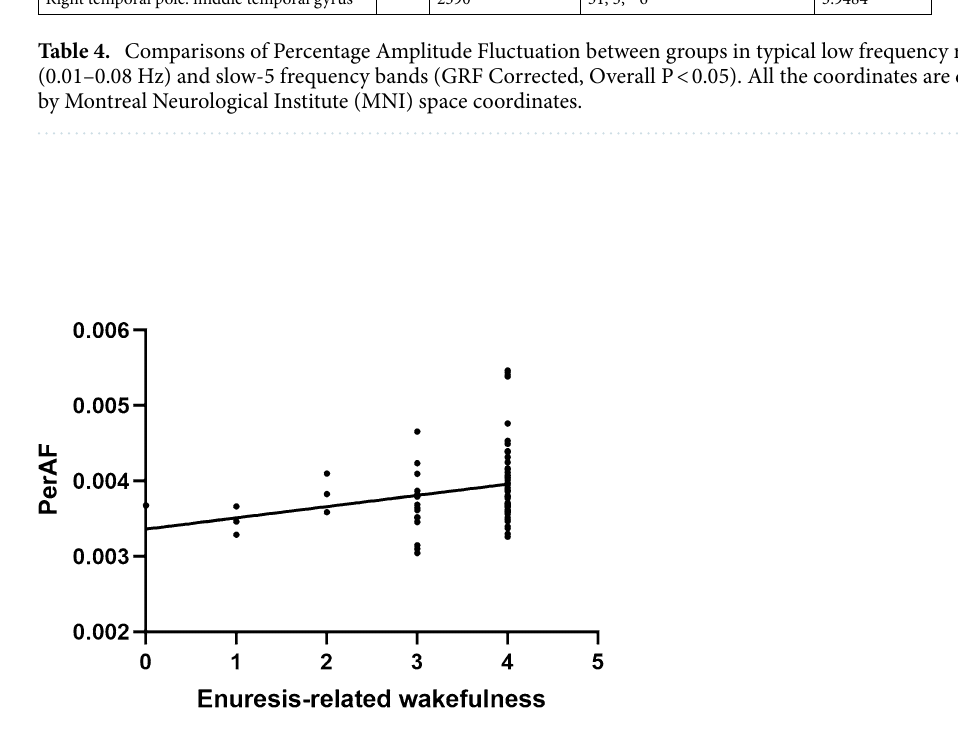
Figure 4. PerAF in middle temporal gyrus was positively associated with scores of urinary intention-related